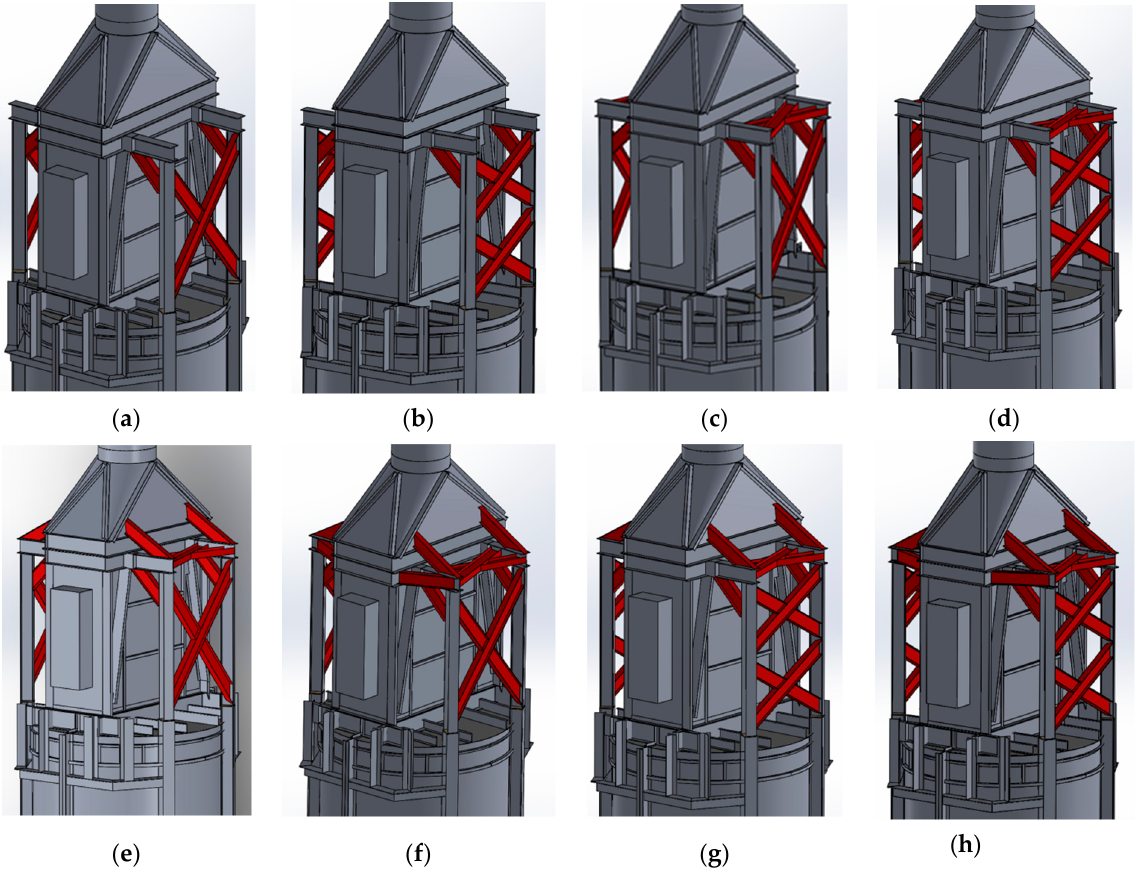
Figure 8. Eight different kinds of reinforcement methods for the support frame. ( a ) Case 1; ( b ) Case 2; ( c ) Case 3; ( d ) Case 4; ( e ) Case 5; ( f ) Case 6; ( g ) Case 7; ( h ) Case 8.